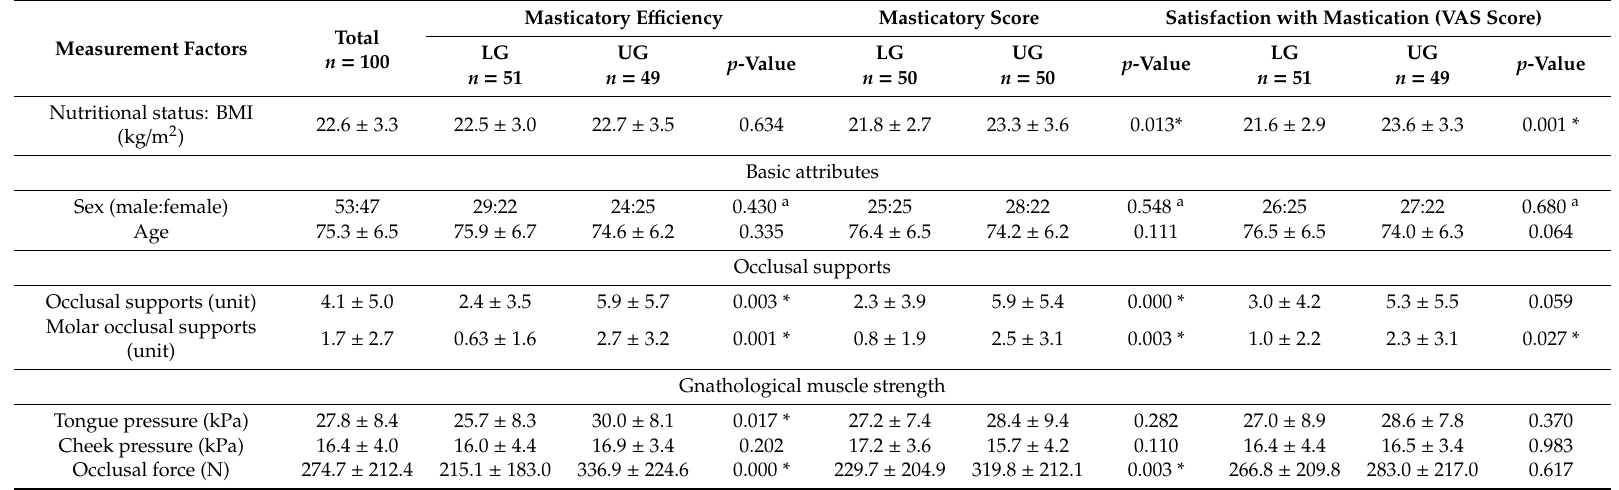
Table 3. Di ff erences in measurement factors between the upper and lower category groups in assessments of masticatory